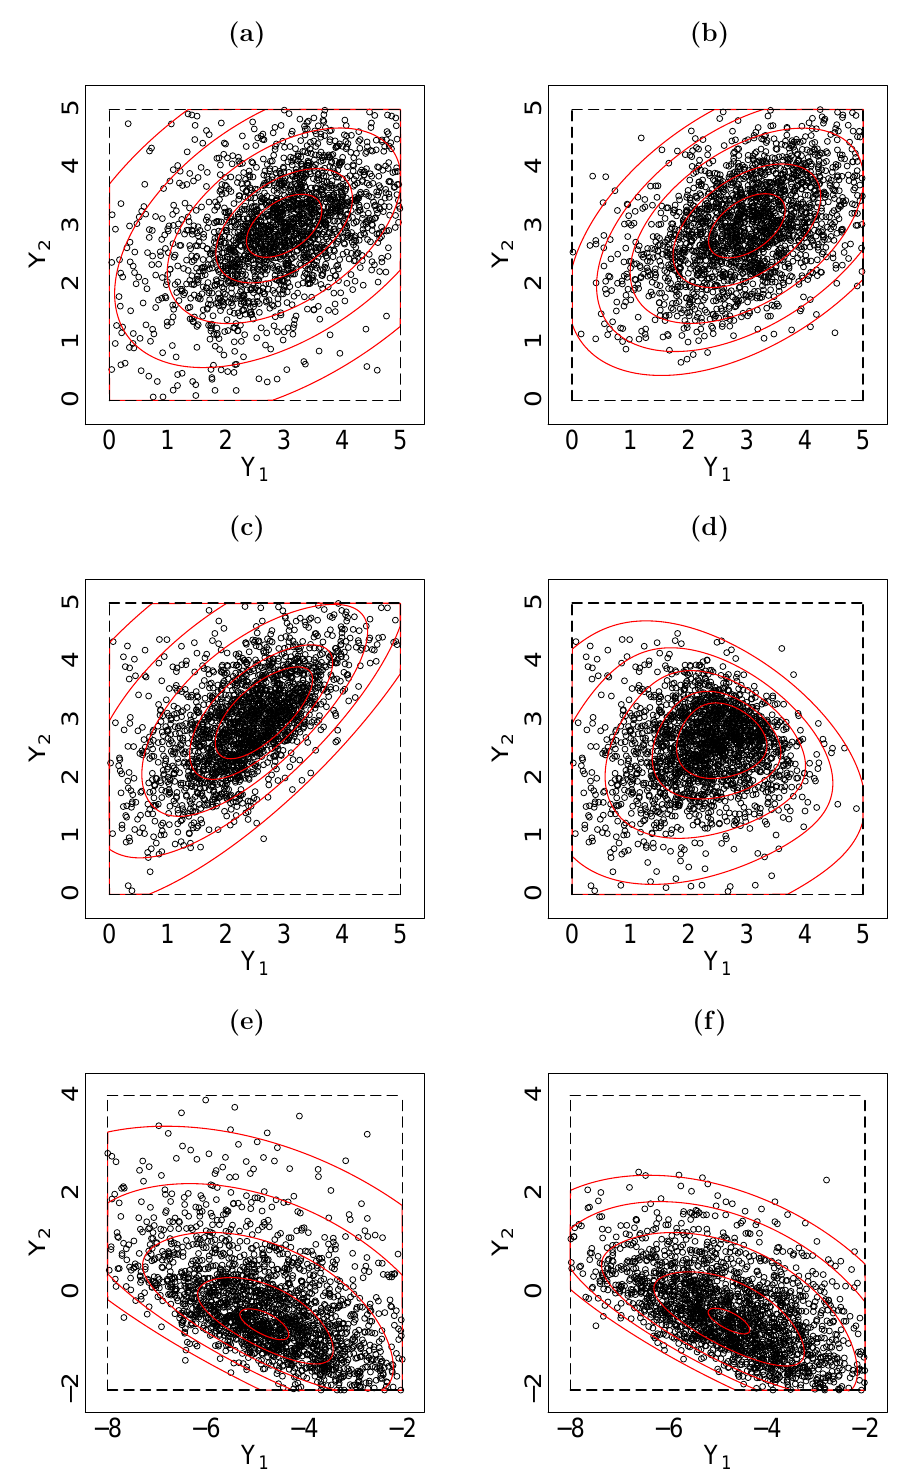
Figure 2. Scatter plots of simulated random samples overlaid with contour plots (at levels 0.18, 0.1, 0.03, 0.008, 0.002) of the PDF of Y ∼ TST 2 ( ξ , Ω , α , ν ; R ) . For plots ( a – d ): ξ 1 = ξ 2 = 3, ω 11 = 1, ω 22 = 0.7, ω 12 = 0.4, R = ( 0,5 ) × ( 0,5 ) , and ( a ) α 1 = α 2 = 0 and ν = 4, ( b ) α 1 = α 2 = 0 and ν = 3000, ( c ) α 1 = − 2, α 2 = 1.5 and ν = 4, ( d ) α 1 = α 2 = − 2 and ν = 4. For plots ( e , f ): ξ 1 = − 5, ξ 2 = − 1, ω 11 = 2, ω 22 = 1.2, ω 12 = − 0.5, R = ( − 8, − 2 ) × ( − 2,4 ) , and ( e ) α 1 = 2, α 2 = 3 and ν = 4, ( f ) α 1 = 2, α 2 = 3 and ν =